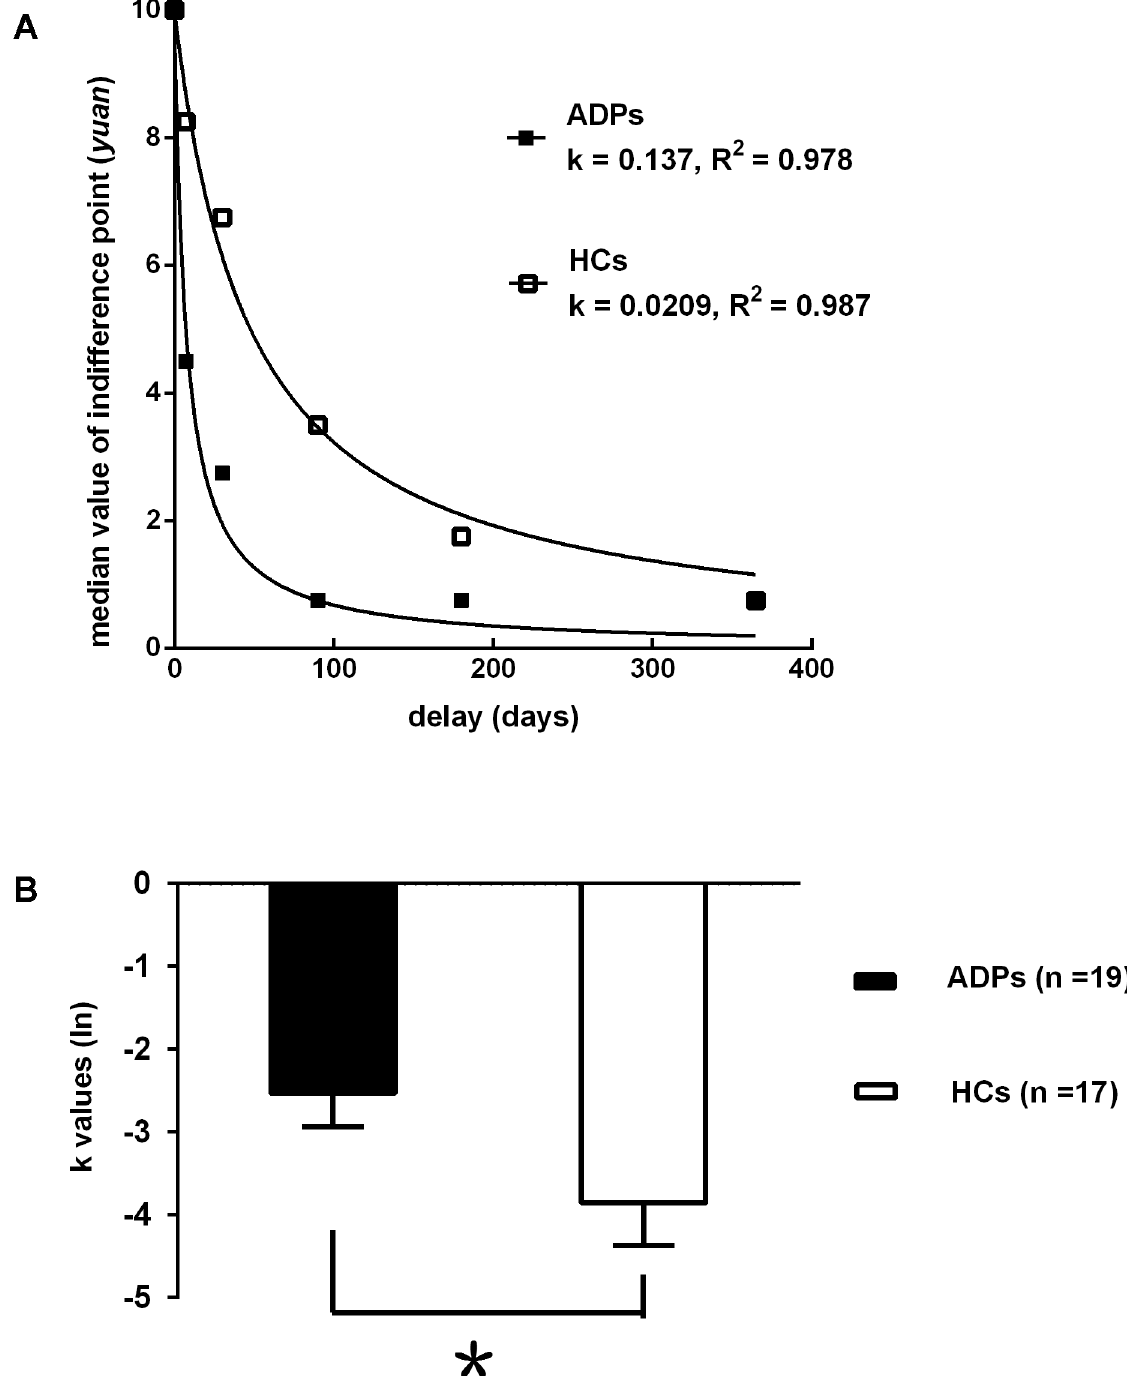
Fig 1. (A) Delay discounting in ADPs and HCs. Data points represent the median indifference points at each time delay. The lines reflect the best fit of the hyperbolic function V = 10/(1+k * D) to the median group indifference points. The rate of discounting for each group (k value) and the goodness of fit for both function are also shown. (B) Mean (ln) k-values when the hyperbolic function is fitted to the data for each subject.Smaller (ln) k-values indicate greater discounting. Err bars represent SEM. The distribution of k values was extremely positively skewed and leptokurtic and the group variances were significantly heterogeneous. Therefore, a natural logarithm (ln) transformation was computed before performing the t test analyses. * p < 0.05 compared with HCs.